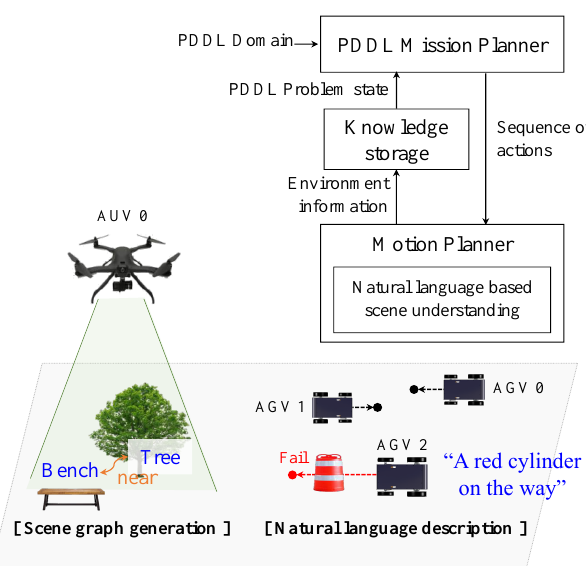
Figure 1. Outline of our approach: PDDL mission planner is utilized to generate the sequence of actions using the PDDL domain and environment information for heterogeneous robots. The surrounding environment is represented as a scene graph. If a robot fails the mission, it generates a natural language